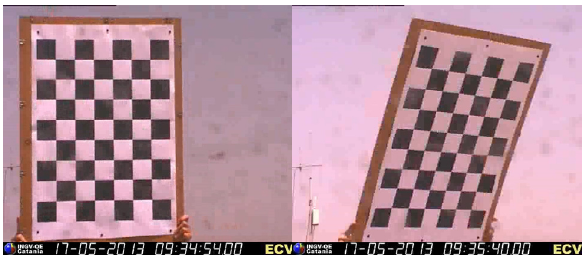
Figure 1. The pattern used for the camera calibration.